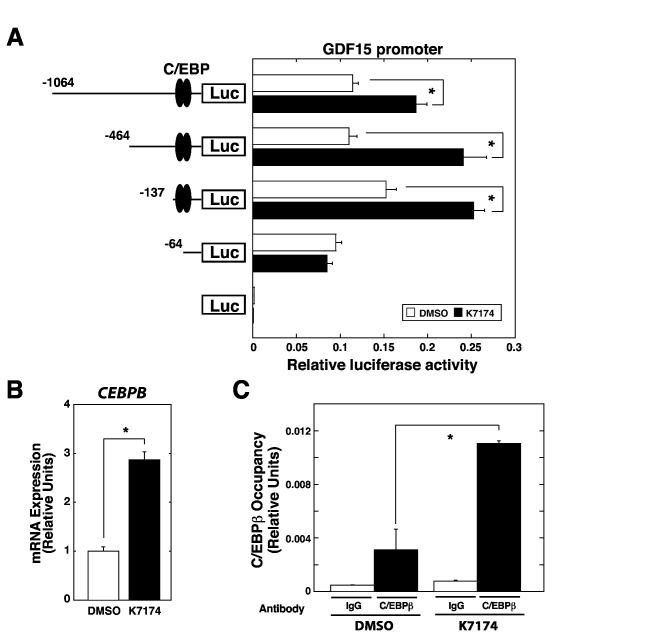
C/EBP binding sites in the GDF15 promoter are important for K7174-mediated transcriptional activation.(A) Transient human GDF15 gene promoter analysis in control (DMSO) or K7174-treated HepG2 cells. A series of 5’ deletion mutants of the human GDF15 gene promoter were assayed for luciferase activity (n = 3, mean ± SE, * P < 0.05). (B) Quantitative RT-PCR analysis of HAMP expression in control (DMSO) or K7174-treated HepG2 cells. The expression level of each target gene relative to that of GAPDH was calculated (n = 3, mean ± SE, * P < 0.05). The expression level of DMSO-treated control cells was set to 1. (C) Quantitative ChIP analysis in control (DMSO) or K7174-treated HepG2 cells to detect CEBPB chromatin occupancy at GDF15 promoter (n = 3, mean ± SE, * P < 0.05).